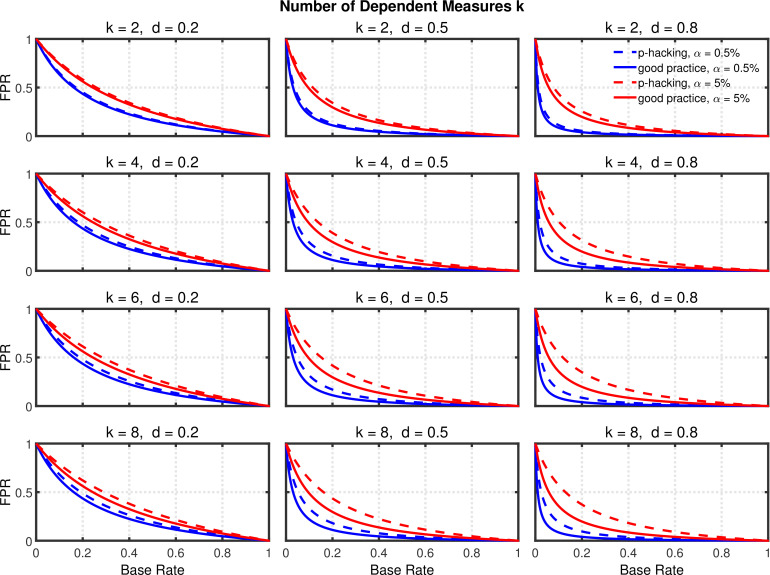
Failing to Report all Dependent Measures.False positive rate (FPR) as a function of base rate π, number of dependent measures k, effect size d, and nominal α level (0.5% or 5%). The nominal α level and power of the replication study are α2=5% and 1-β2=90%. All results are based on two-sample tests with n=20 participants per group and dependent measure intercorrelations of 0.8.